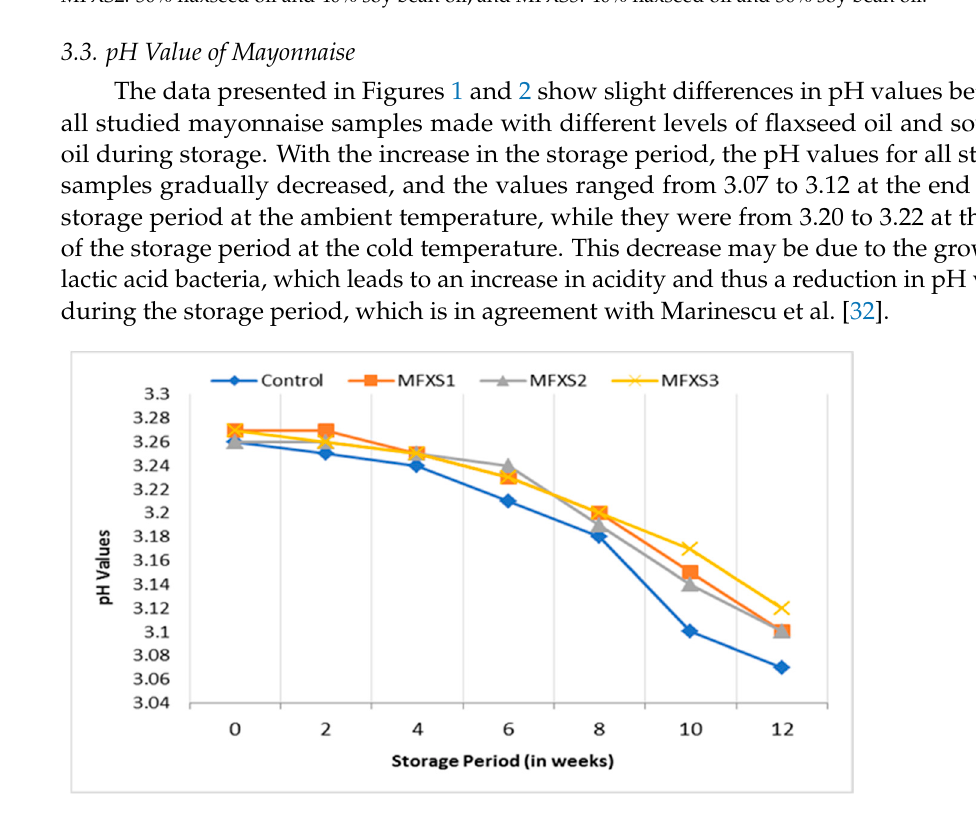
Figure 1. pH values of mayonnaise samples during ambient storage (25 ± 5 °C). Control sample: 70%